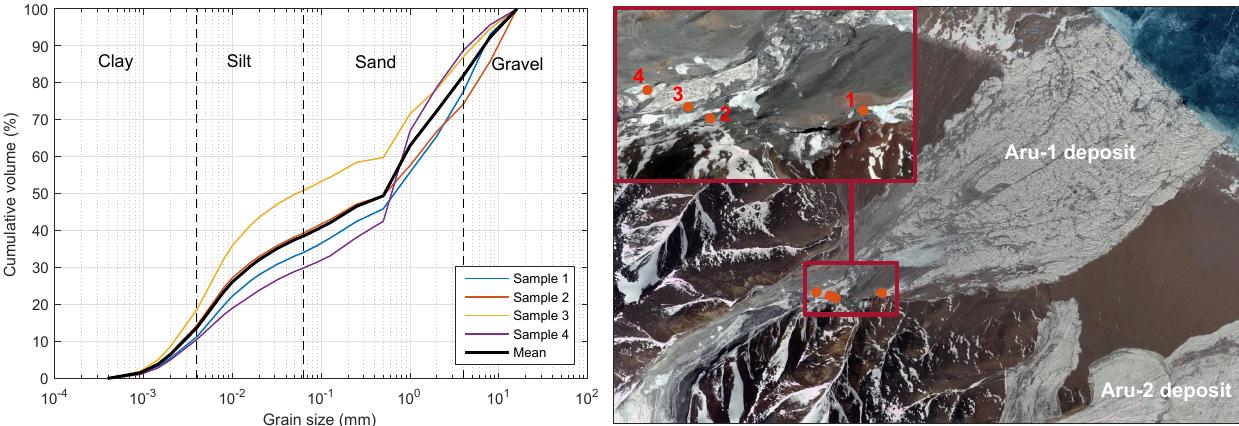
Figure 12. Grain-size distribution measured in four glacier till samples collected in the Aru-1 deposit area (numbers 1 to 4 in the right panel). Background image from Google